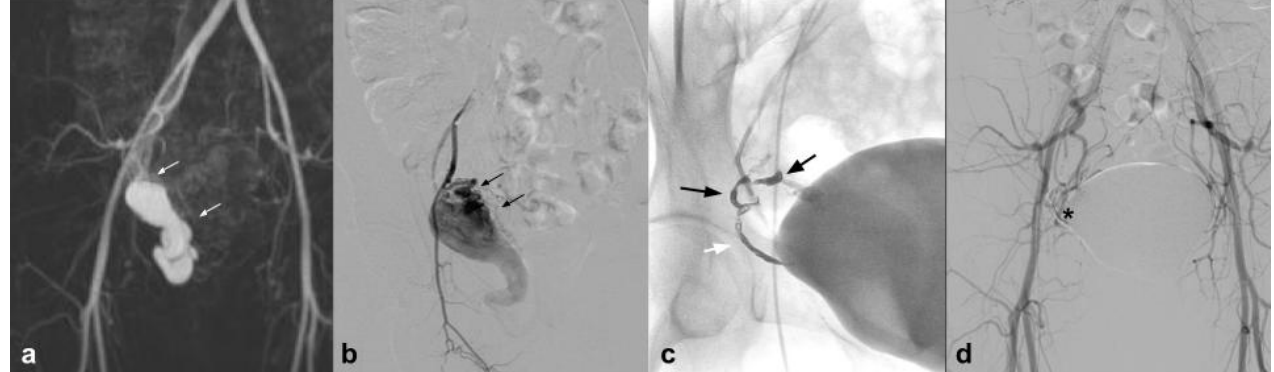
Figure 1. ( a ). Coronal CEMRA MIP demonstrates the presence of voluminous AVM originating from the right uterine artery with aneurysmal venous outflow (white arrows); ( b ) DSA performed with a vertebral shape catheter in the ipsilateral hypogastric artery confirms the presence of the AVM highlighting the “nidus” (black arrows); ( c ) single-shot post-treatment fluoroscopy shows the inferior uterine artery treated (white arrow) with coils (not directly tributary of the AVM) and the presence of a cast of Squid 12 at the level of the middle and inferior uterine artery which were the arterial feeding vessels of the AVM (black arrows); ( d ) post-procedure DSA demonstrates the complete exclusion of the treated AVM (asterisk).